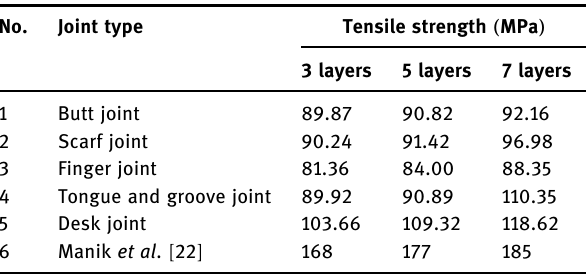
Table 8: Comparison of tensile strength under di ff erent joint types No.